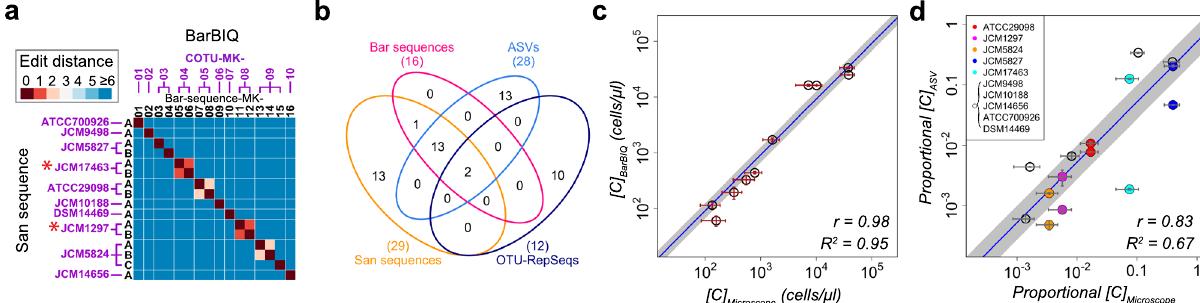
Fig. 2 Ef fi cacy of BarBIQ for the mock community and comparison with the conventional methods. a Comparison of the 16S rRNA sequences identi fi ed by Sanger sequencing and by BarBIQ. Edit distance, Levenshtein distance 68 , de fi ned as the minimum number of substitutions, insertions, and deletions; San sequence, Sanger sequencing-identi fi ed 16S rRNA sequence; ATCC/JCM/DSM <number>, strain ID; A, B, or C, San sequences for each strain; Bar- sequence-MK-<number>, BarBIQ-identi fi ed sequences (Bar sequences); COTU-MK-<number>, cell-based operational taxonomy units (cOTUs); red star, Bar sequences that had one base difference. Source data are provided as a Source Data fi le. b Comparison (Venn diagram) among San sequences identi fi ed from each of the ten strains, Bar sequences, amplicon sequence variants (ASVs), and the representative sequences of operational taxonomy units (OTU- RepSeqs) identi fi ed from the mock community. Circle, total sequences from each method; numbers in circles, number of unique or identical sequences detected by the given method(s); numbers in the parentheses, total number of sequences detected by the given method. c Comparison of the absolute cell ( [C] Microscope ) (Supplementary Table 1). Data are presented as mean values ± SD ( n = 3 for [C] BarBIQ , n = 5 for [C] Microscope ). Blue thin line, a fi tting line with a